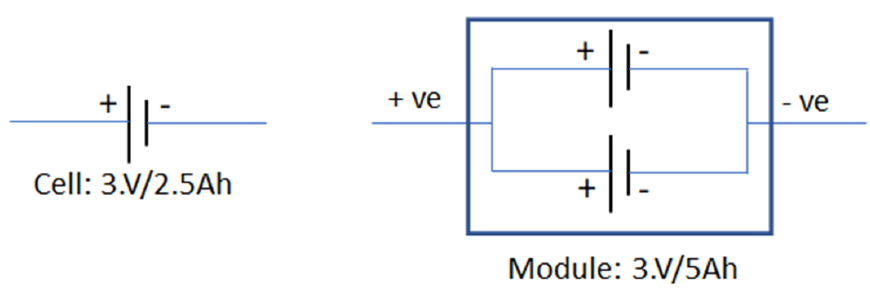
Figure 1. Cell and module